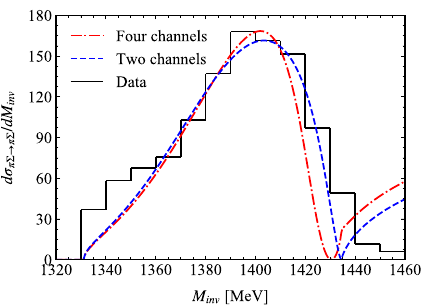
Fig. 1 π(cid:4) invariant mass spectrum of the channel π(cid:4) → π(cid:4) with a normalization coefficient C = 113 for four coupled channels and C = 110 for two coupled channels. Data are taken from Ref. [85]